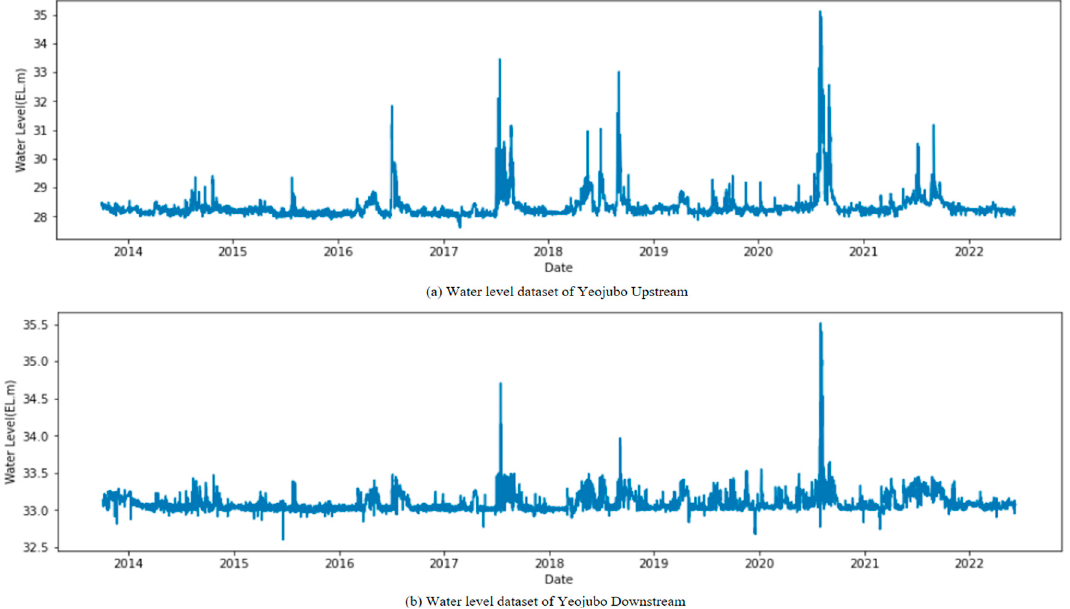
Figure 4. Water level dataset visualization. ( a ) Water level dataset upstream of Yeojubo; ( b ) water level dataset downstream of Yeojubo.